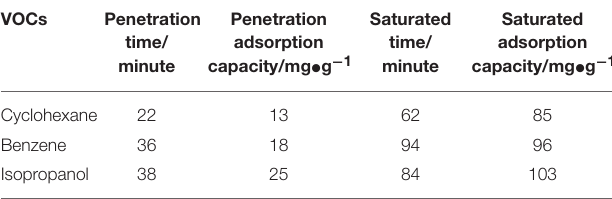
TABLE 6 | Adsorption performance of VOCs by activated